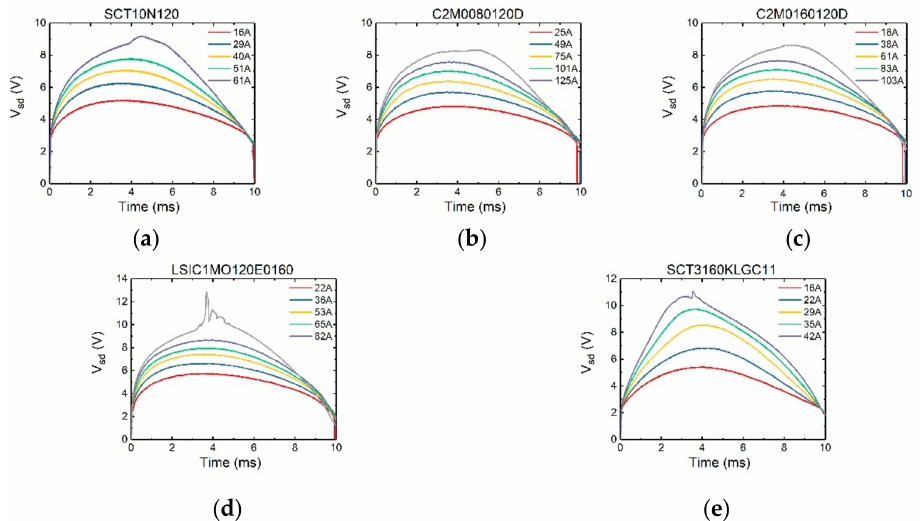
Figure 4. The variation of voltage V sd of ( a ) SCT10N20, ( b ) C2M0080120D, ( c ) C2M0160120D, ( d ) LSIC1MO120E0160, ( e ) SCT3160KLGC11 SiC MOSFETs when varying surge current amplitude with V gs = − 3